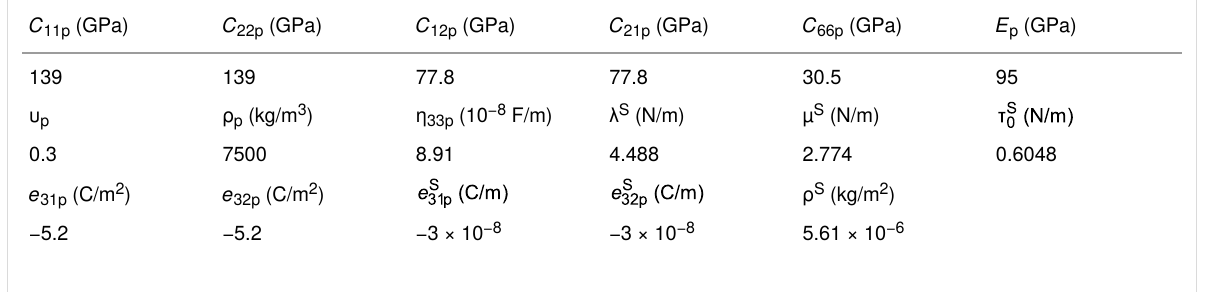
Table 3: Surface and bulk properties of PZT-4 piezoelectric